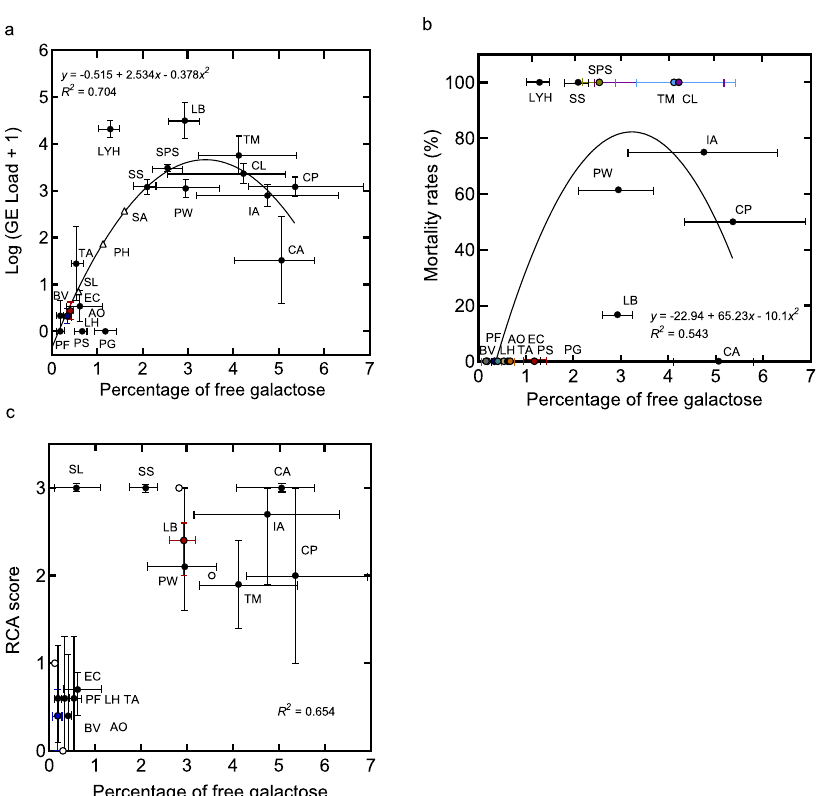
Fig. 6 Free galactose levels as a biomarker for infection intensity. a Percentage of free galactose per total carbohydrate in mucosome washes, calculated per square centimetre of body surface, in relation to B. salamandrivorans infection peak loads of different amphibian species. B. salamandrivorans infection peak loads are expressed in log (genomic equivalents (GE) load + 1). Vertical error bars indicate standard error of mean. b Percentage of free galactose per total carbohydrate in mucosome washes, calculated per square centimetre of body surface, in relation to mortality rates of different amphibian species. c Percentage of free galactose per total carbohydrate in mucosome washes, calculated per square centimetre of body surface, in relation to intensity of RCA staining. Vertical error bars indicate minimum and maximum RCA scores. a , c Horizontal error bars indicate minimum and maximum of percentage of free galactose. Black and coloured dots represent the mean value overall. R 2 indicates the coef fi cient of multiple determination. a, b The regression analyses were performed by quadratic regression. White triangles represent the predicted infection peak load values calculated by the equation of quadratic regression model. Line indicates quadratic regression. c Linear regression was performed using dummy variables for RCA scores. White dots represent the predicted values of percentage of free galactose for each RCA score generated by the regression model. RCA score: 0 = negative staining, 1 = weak staining, 2 = strong staining, 3 = intense staining. a , c Urodele species: LH = Lissotriton helveticus , PW = Pleurodeles waltl , LB = Lissotriton boscai , TA = Triturus anatolicus , TM = Triturus marmoratus , CP = Cynops pyrrhogaster , IA = Ichthyosaura alpestris , SS = Salamandra salamandra , LYH = Lyciasalamandera helverseni , SPS = Speleomantes strinatii , PH = Paramesotriton hongkongensis , PG = Plethodon glutinosus , CL = Chioglossa lusitanica , PS = Pachyhynobius shangchengensis , CA = Calotriton asper , SA = Salamandra algira and SL = Salamandra lanzai . Anuran species: AO = Alytes obstetricans , BV = Bombina variegata , EC = Epidalea calamita and PF = Pelobates fuscus . Number of biologically independent animals used for measuring the percentage of free galactose in mucosome washes: LH ( n = 3), PW ( n = 3), LB ( n = 3), TA ( n = 3), TM ( n = 3), CP ( n = 3), IA ( n = 3), SS ( n = 3), LYH ( n = 3), SPS ( n = 2), PH ( n = 2), PG ( n = 2), CL ( n = 3), PS ( n = 3), CA ( n = 3), SA ( n = 3), SL ( n = 2), AO ( n = 3), BV ( n = 2), EC ( n = 3) and PF ( n = 3). Number of biologically independent animals in infection trials: LH ( n = 23), PW ( n = 13), LB ( n = 6), TA ( n = 6), TM ( n = 6), CP ( n = 8), IA ( n = 20), SS ( n = 26), LYH ( n = 3), SPS ( n = 3), PG ( n = 5), CL ( n = 6), PS ( n = 3), CA ( n = 5), AO ( n = 13), BV ( n = 4), EC ( n = 5) and PF ( n = 5). Number of biologically independent animals used for RCA staining: LH ( n = 13), PW ( n = 11), LB ( n = 3), TA ( n = 3), TM ( n = 3), CP ( n = 3), IA ( n = 12), SS ( n = 10), CA ( n = 10), AO ( n = 10), RT ( n = 10), BV ( n = 5), PF ( n = 5) and EC ( n = 5). Source data are provided as a Source Data fi